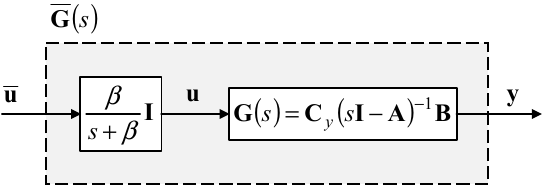
Figure 2. Modified plant model with a low-pass filter.